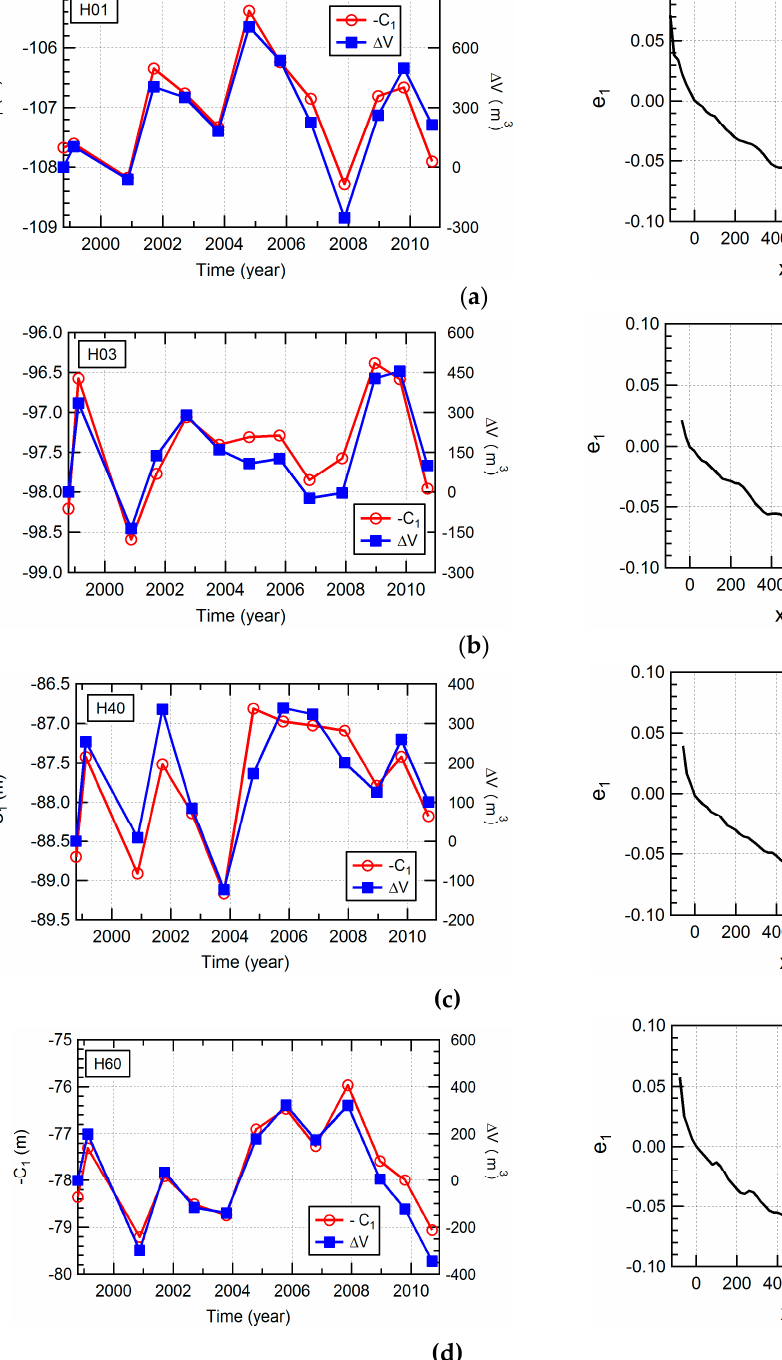
Figure 16. Temporal and spatial eigenfunctions of the first mode.